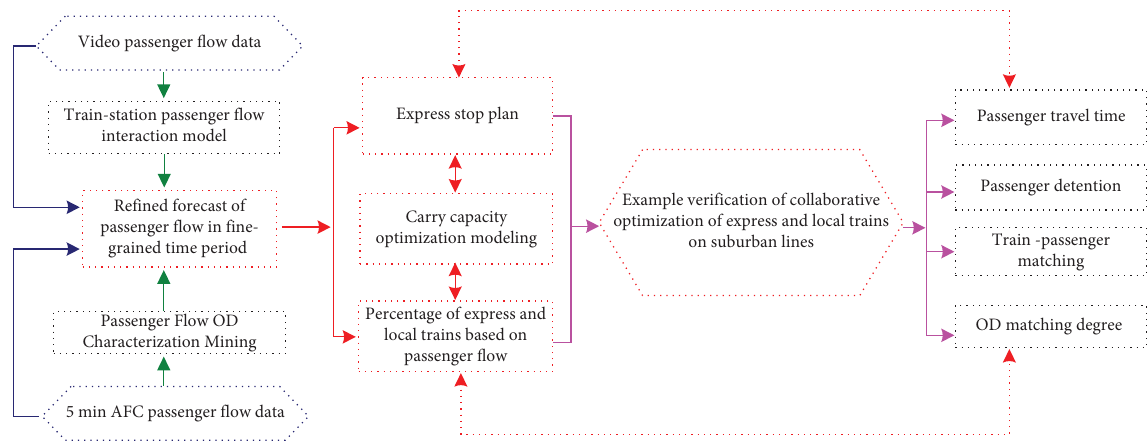
Figure 6: Te fow chart of the case study for the experimental